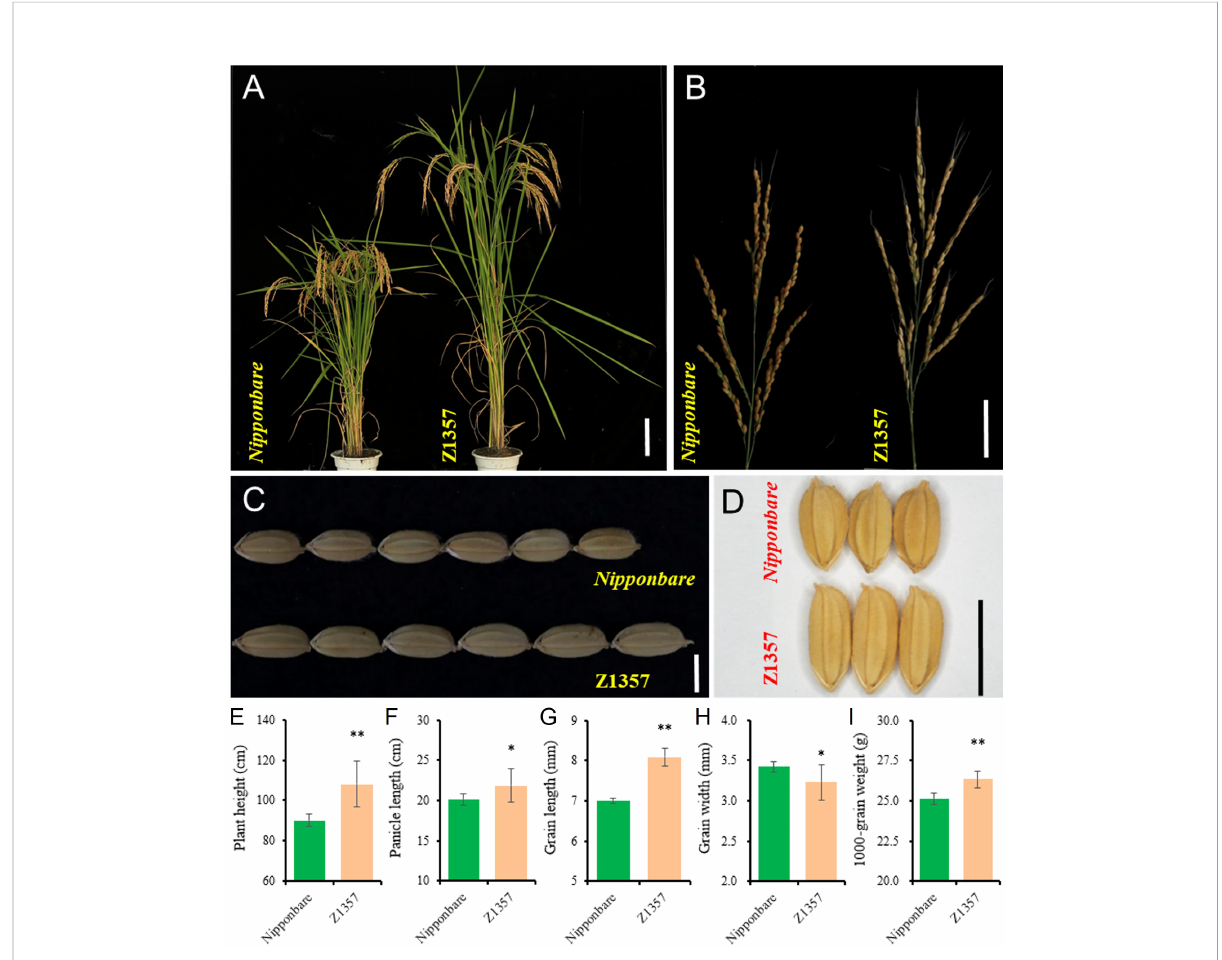
FIGURE 1 Phenotypes of Nipponbare and Z1357. (A) Plant architecture of Nipponbare and Z1357; (B) Panicles of Nipponbare and Z1357; (C, D) Phenotypes of grain length (C) and width (D) of Nipponbare and Z1357; (E – I) Comparison of PH (E) , PL (F) , GL (G) , GW (H) , and TGW (I) between Nipponbare and Z1357. Bar in A refers to 20 cm, in B to 5 cm, in C and D to 1 cm. * and ** refer to the signi fi cant differences at P < .05 and P < .01, respectively, by the